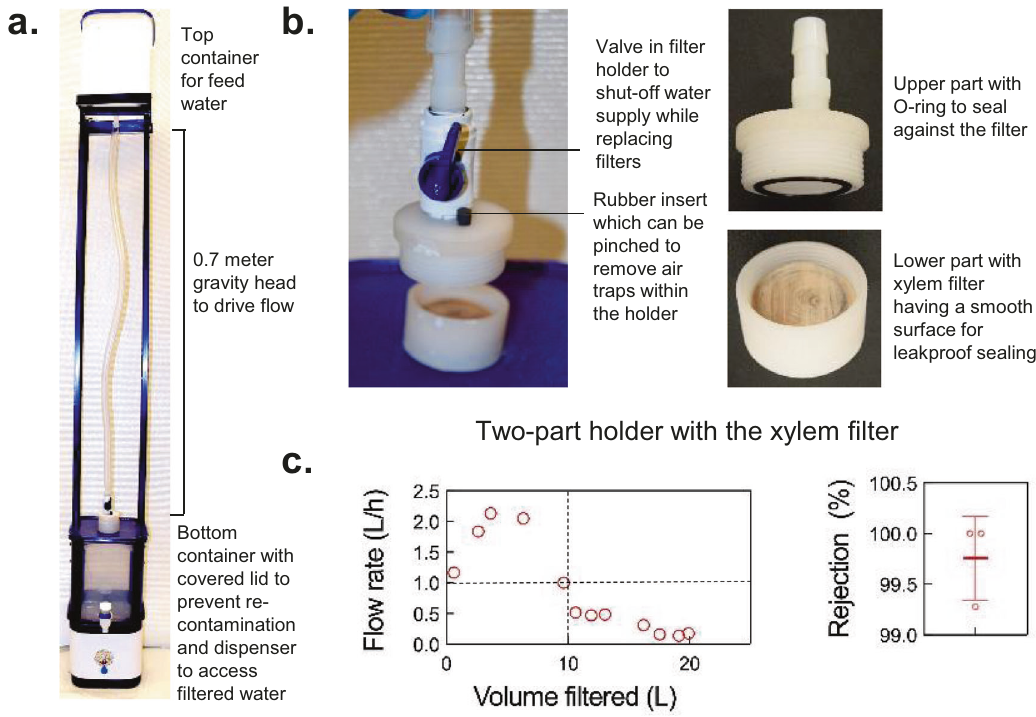
Fig. 6 Xylem fi lter device prototype. a , b Device prototype and its components. c Device fl ow rate with tap water in New Delhi and rejection of 1- μ m particles measured in the laboratory are consistent with prior characterization of xylem fi lters. Filters were made from ginkgo of 4-cm diameter and 0.375- inch thickness. For the rejection performance, mean±s.d and individual data points are shown; n = 3 different fi